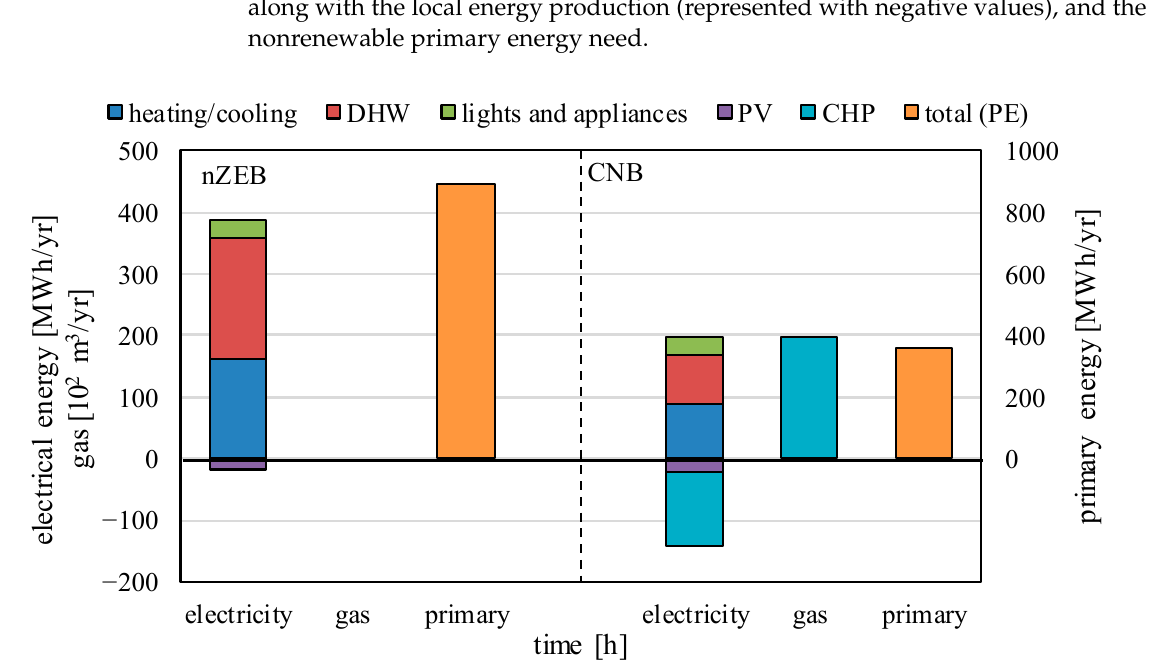
Table 4. nZEB and CNB energy performance per year.